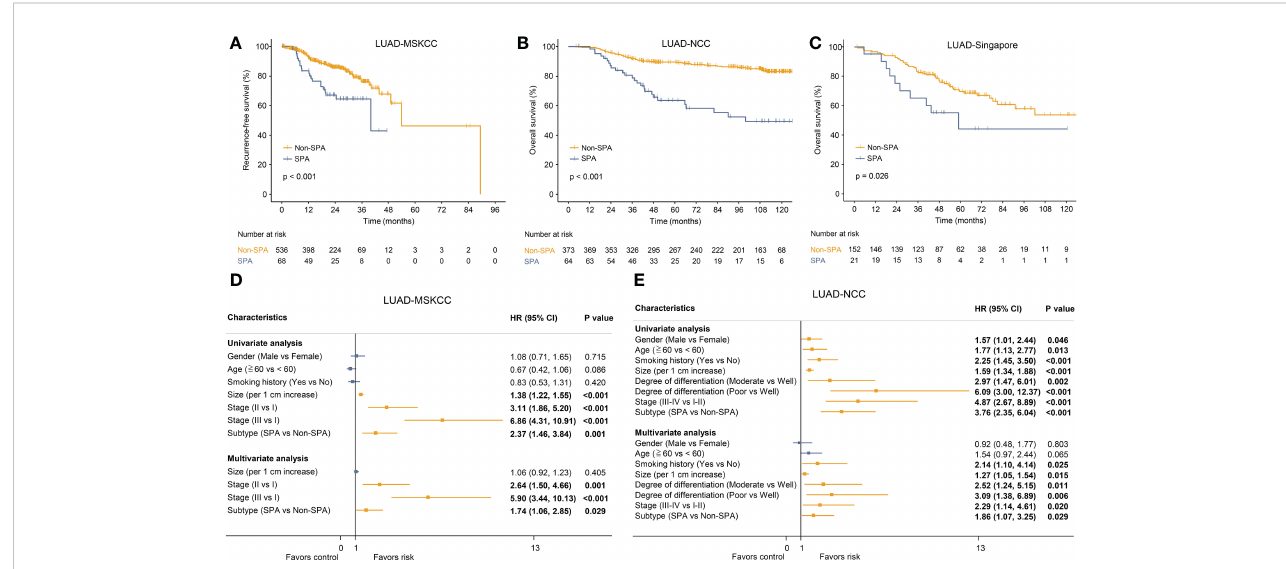
FIGURE 2 Survival analyses of SPA versus Non-SPA. (A) Recurrence-free survival of SPA and Non-SPA in LUAD-MSKCC. (B) Overall survival of SPA and Non-SPA in LUAD-NCC. (C) Overall survival of SPA and Non-SPA in LUAD-Singapore. (D, E) Univariate and multivariate Cox regression analyses of the pathological subtype and other clinicopathologic features regarding prognostic value in LUAD-MSKCC and LUAD-NCC. SPA, solid predominant adenocarcinoma; Non-SPA, non-solid predominant adenocarcinoma; CI, con fi dence